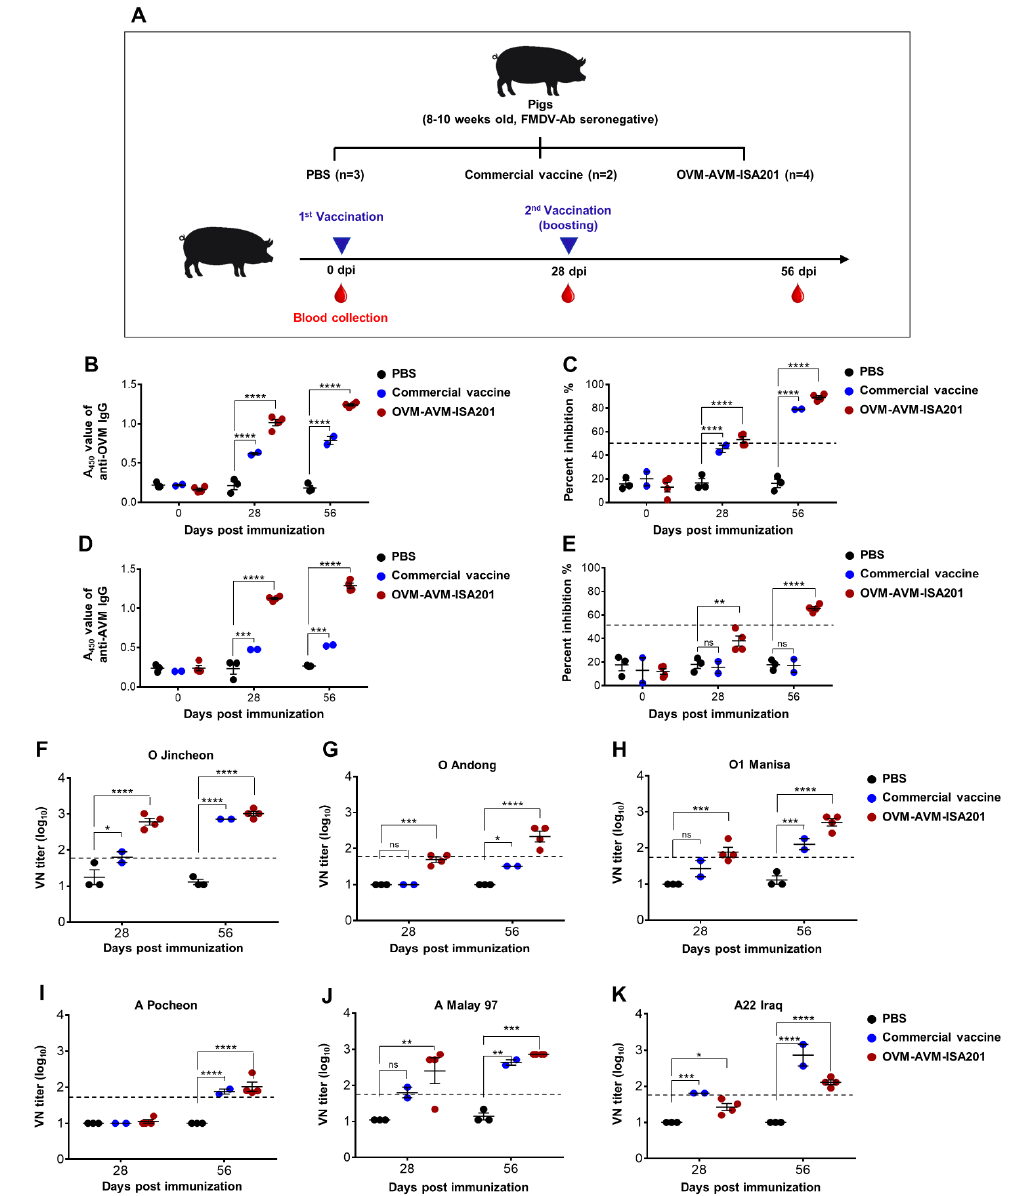
Figure 5. OVM-AVM-ISA201 induced immune response in pigs. For the target animal immuniza- tion experiment, FMDV serotype O and serotype A antibody seronegative 8 – 10-week-old pigs were used. As the strategy depicted in Figure 5A, pigs were divided into 3 groups. The test vaccine group ( n = 4) was immunized with 250 µg of OVM and 250 µg of AVM emulsified with ISA201. The posi- tive control group ( n = 2) received the commercial trivalent vaccine. The negative control group ( n = 3) received the same volume of PBS. Immunization was performed twice at a 28-day interval. Blood samples collected at 0, 28, and 56 days post immunization (dpi) were used for serological analysis. ( A ) Schematic depiction of pig immunization strategy. ( B ) OVM-specific total IgG titers were determined by indirect ELISA. ( C ) Serotype O SP-specific IgG titers were determined by SP O ELISA. ( D ) AVM-specific total IgG titers were determined by indirect ELISA. ( E ) Serotype A SP-